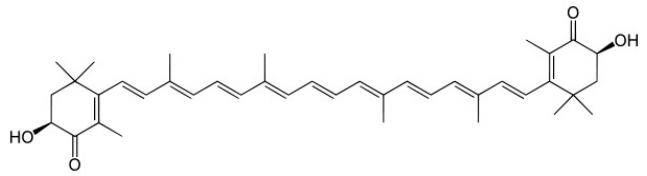
Figure 1. Chemical structure of astaxanthin (AST).